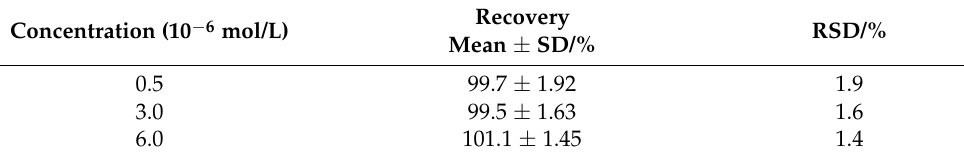
Table 2. Test results of the FEL detection accuracy.